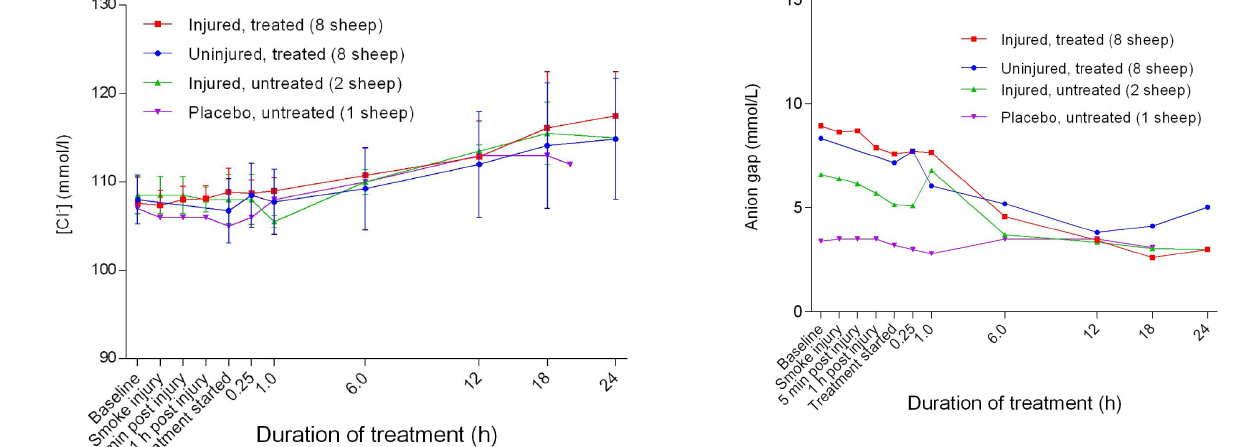
Figure 17. Anion gap (Mean ± SD, error bars not shown) in smoke and non-smoke injured sheep that received extracorporeal life support as compared to that in untreated